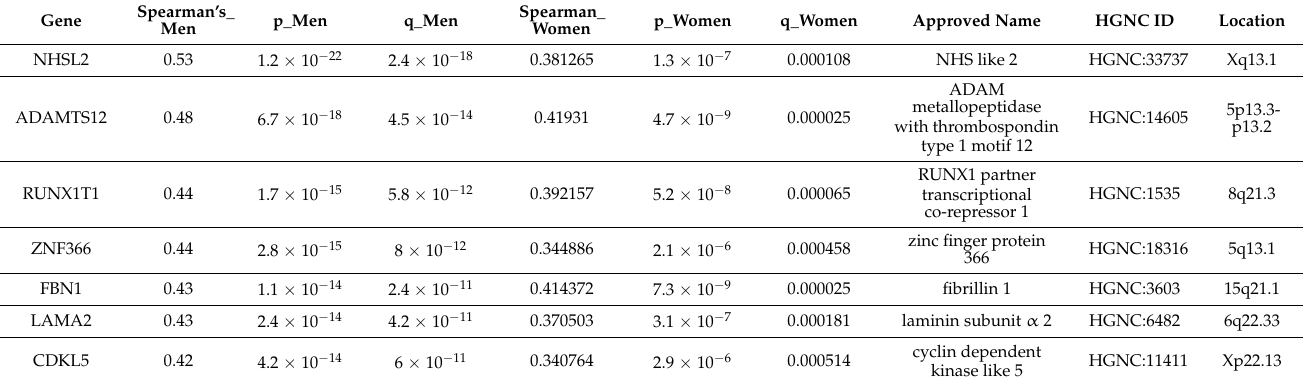
Table A3. AR-co-expressed genes in tumors in both